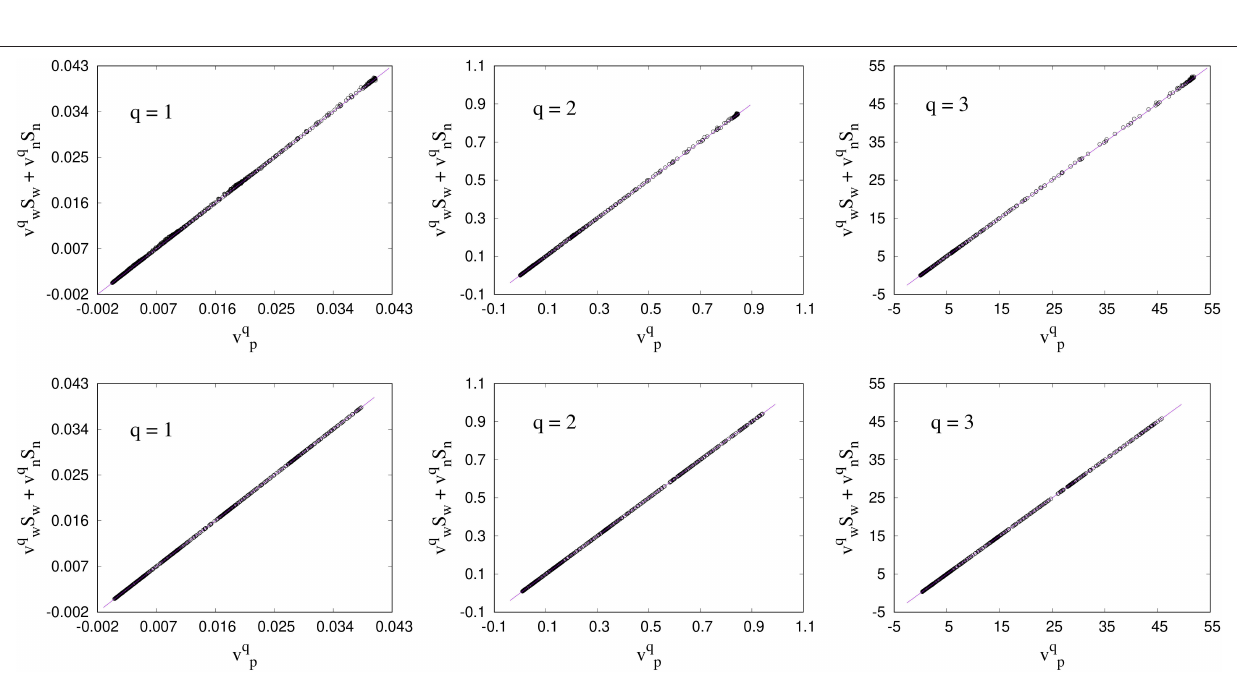
FIGURE 2 | Verification of the relations (11), (45), and (59) between the steady-state seepage velocities v p , v w , and v n , and their higher moments for the 3D Berea network. The direct approach of measurements using Equations (82)–(84) are presented in the top row. The measurements using the differential area distributions defined in Equations (58), (60), and (61) are presented in the bottom row. v p has a unit mm/s. Subsequently, for q mm 3 /s, respectively.